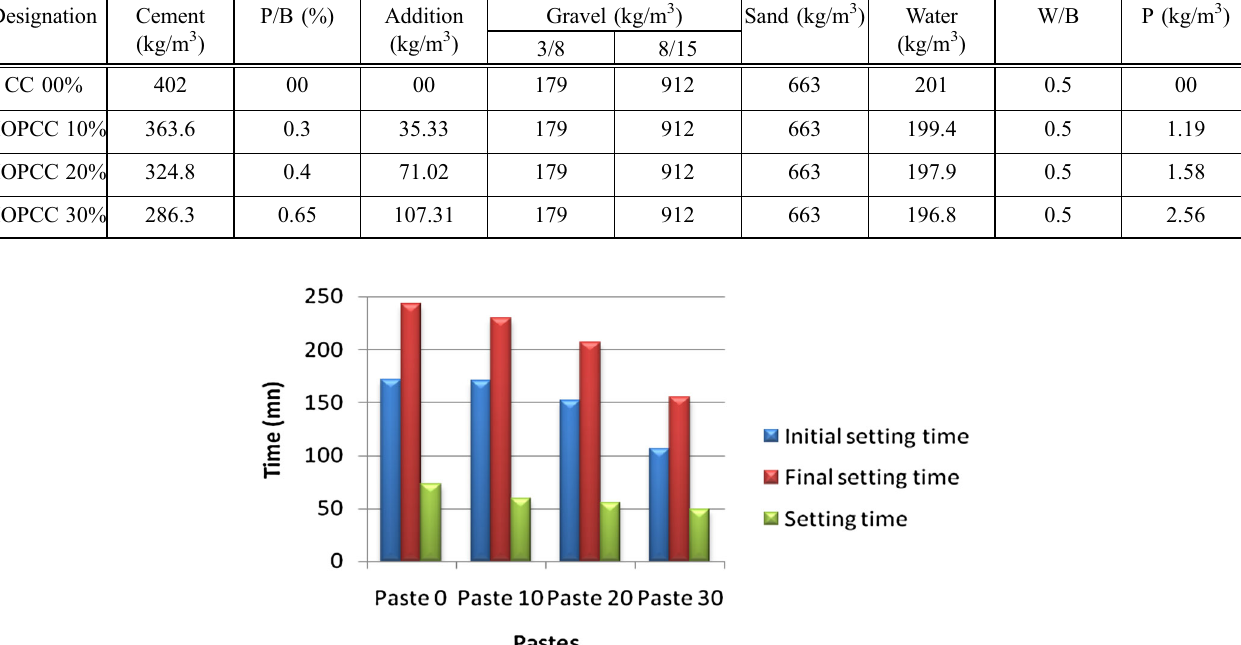
Table 5 Formulation of concretes.